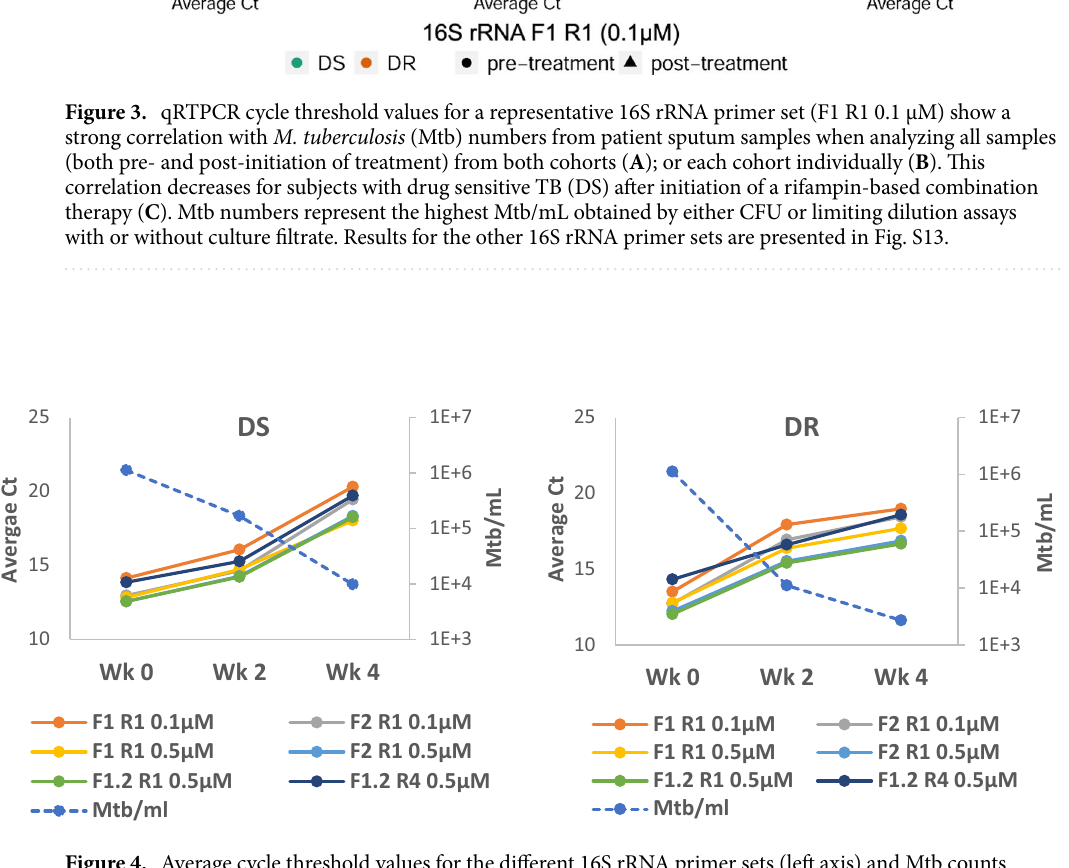
Figure 4. Average cycle threshold values for the different 16S rRNA primer sets (left axis) and Mtb counts (right axis) for sputa from a subject with drug sensitive (DS) or drug resistant (DR) TB during the course of therapy with first-line or second-line drug regimens, respectively. Mtb numbers (shown by dashed line) represent the highest number obtained by either CFU or limiting dilution assays with or without culture filtrate. The final primer set ‘F1.2 R4 0.5 µM’ (dark blue solid line) was unable to distinguish between live/dead H37Rv (Table 4) but was included as a comparator since it has the lowest limit of detection of any 16S rRNA primer set